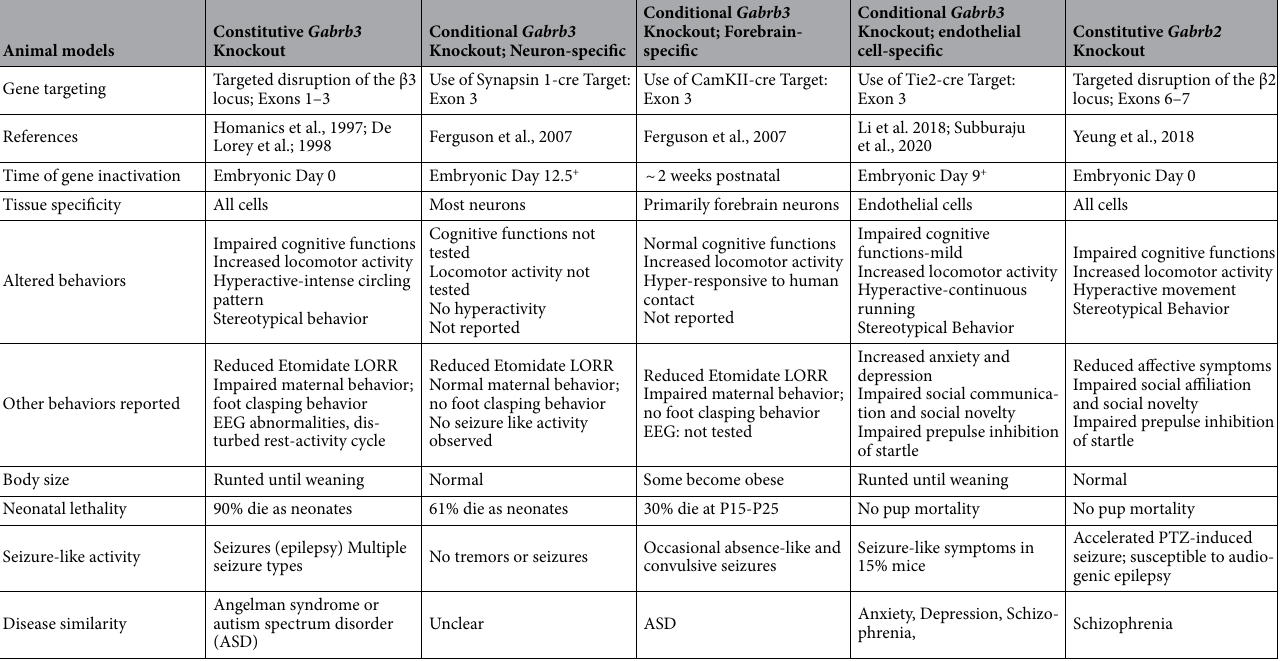
Table 1. This table illustrates the similarities and differences in behavior observed in constitutive versus conditional knockout models of Gabrb3 illustrating cell-type specific roles in behavioral